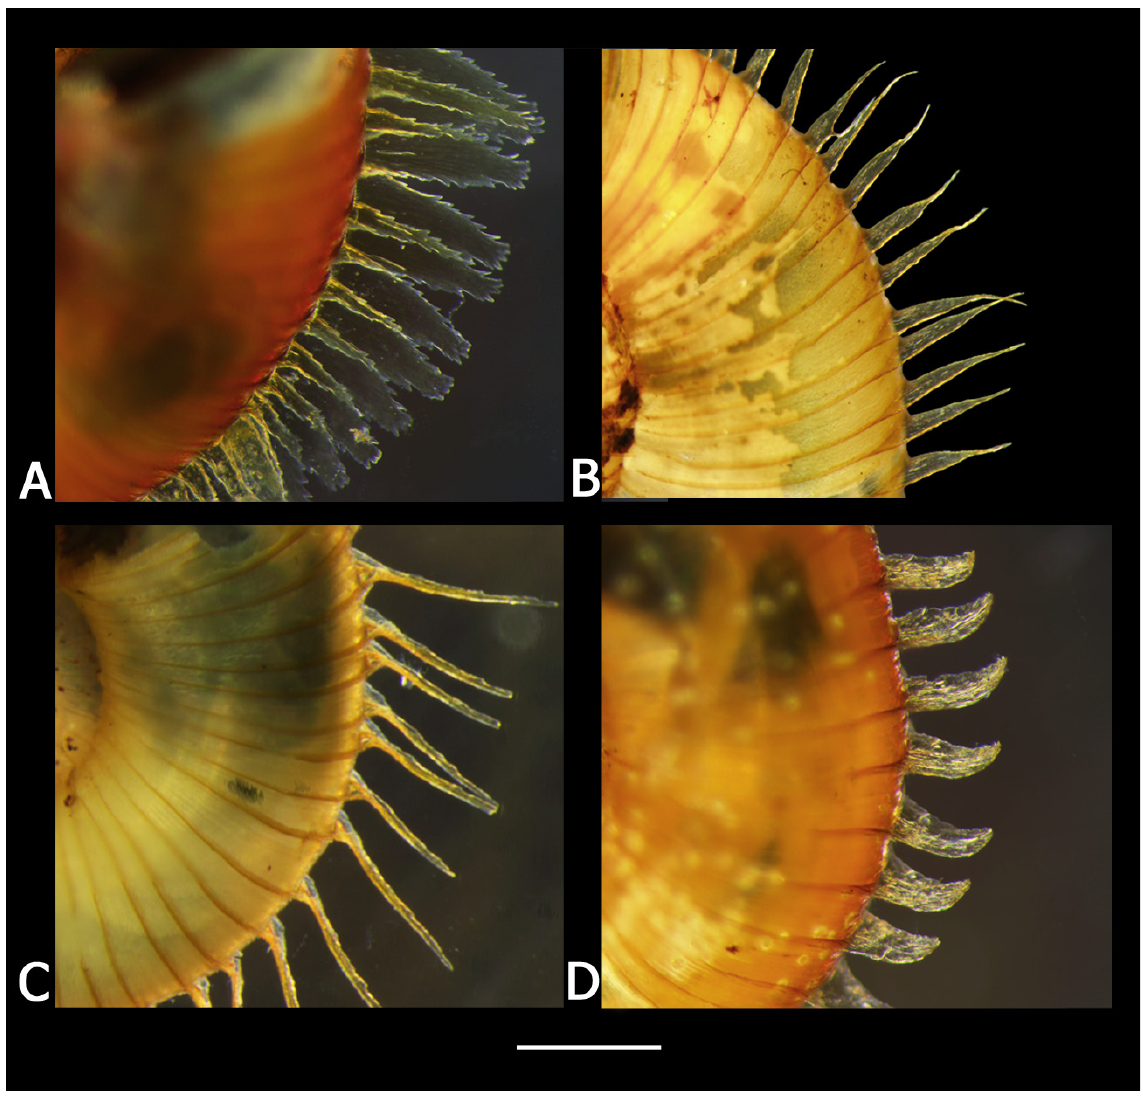
Fig. 8. Close-up of periostracum of species of the Southern-Eastern Cape clade and Chondrocyclus convexiusculus (Pfeiffer, 1855), showing variation in detail of flanges at periphery. A . C. alabastris (Craven, 1880) (serrated edge typical) (ELM W3640). B . C. alabastris , Grahamstown area (ELM